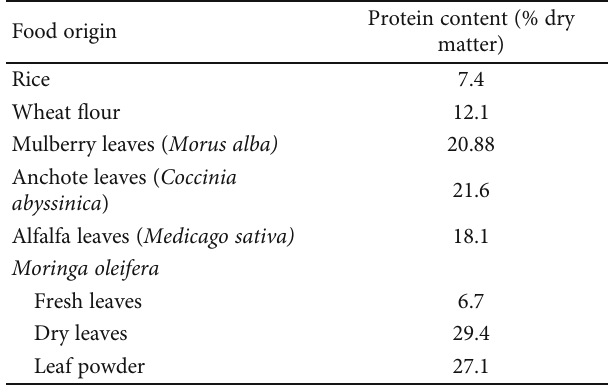
Table 3: Protein content in various plant leaves including